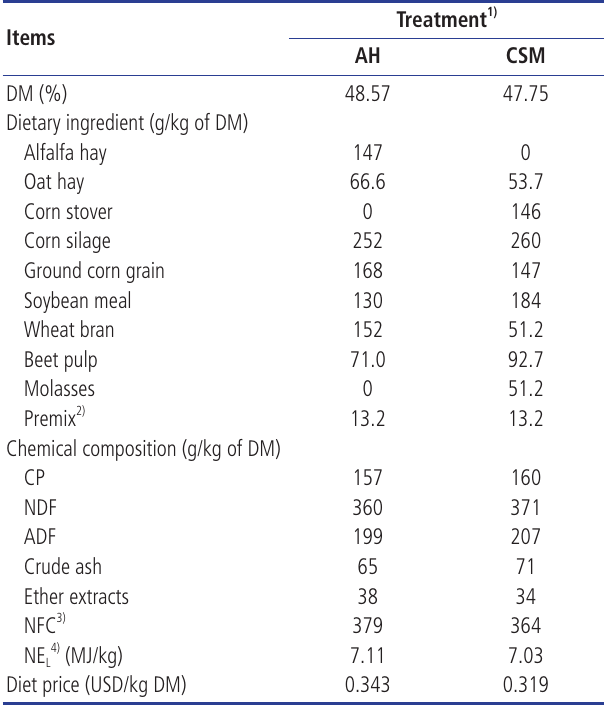
Table 1. Ingredients of the experimental diets